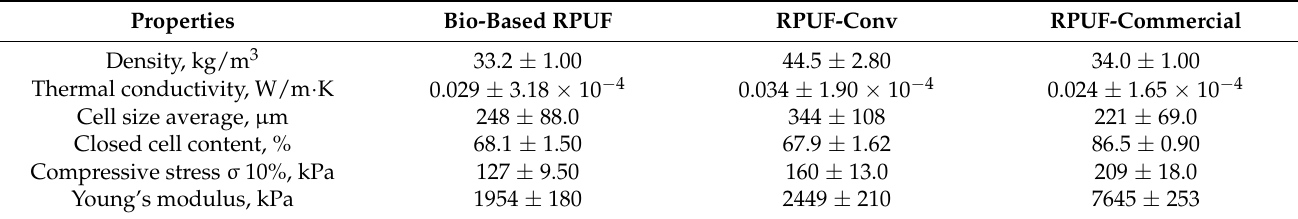
Table 6. Average values of the characteristics of ensuing